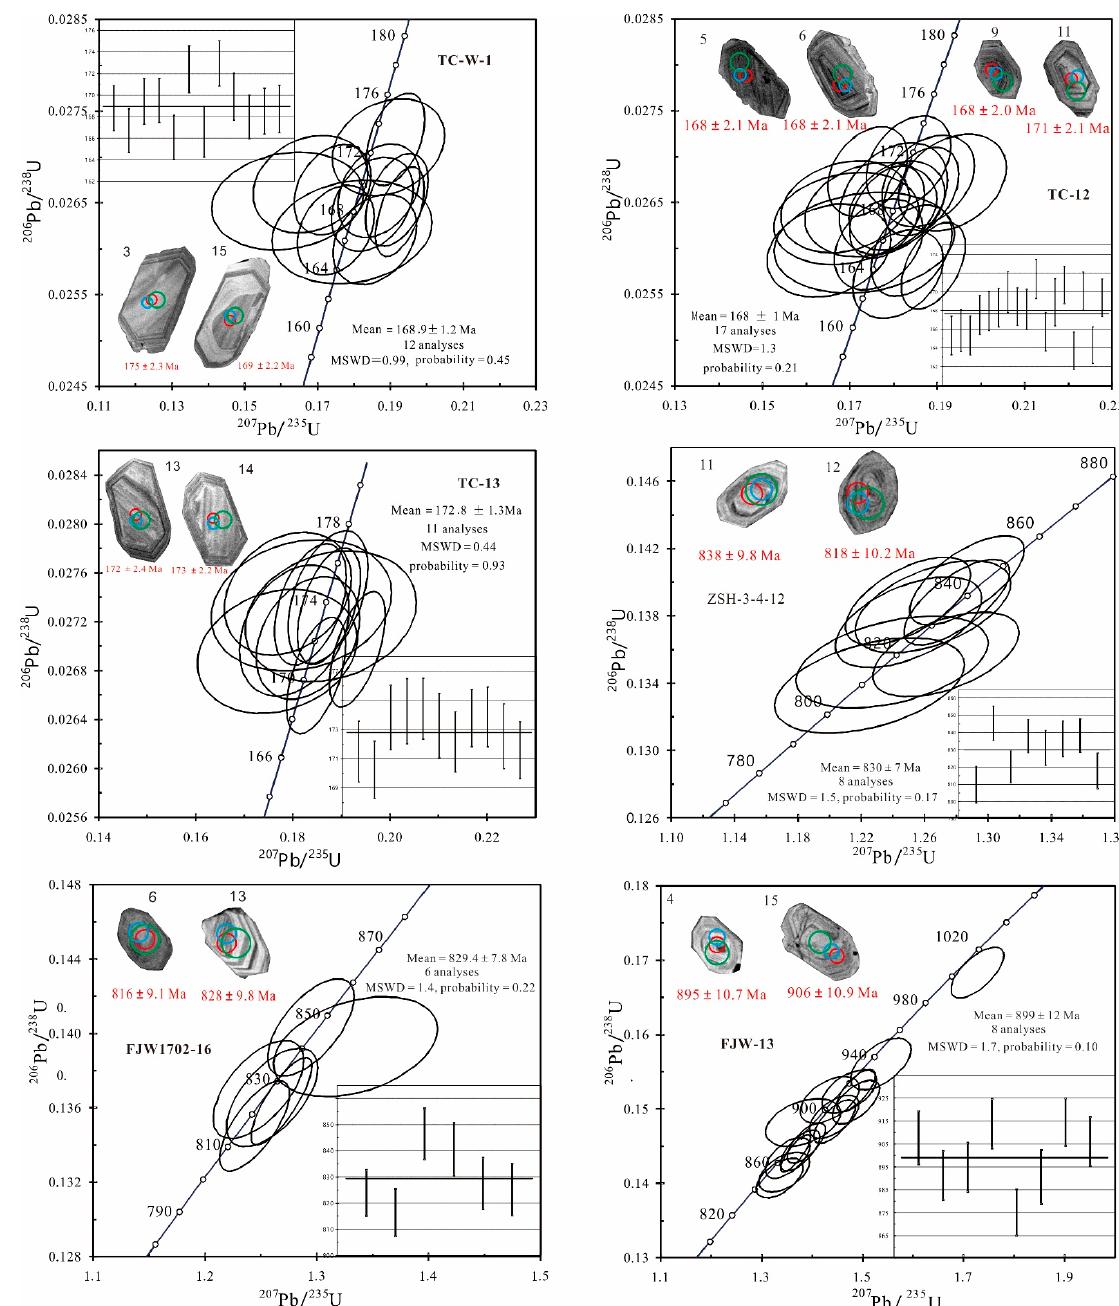
Figure 3. Zircon CL images and SHRIMP U-Pb age distribution from the Dexing copper deposit. Apatite is relatively enriched in the porphyry and wall rocks as an accessory mineral with two different crystallization features (Figure 4). The first type in porphyry